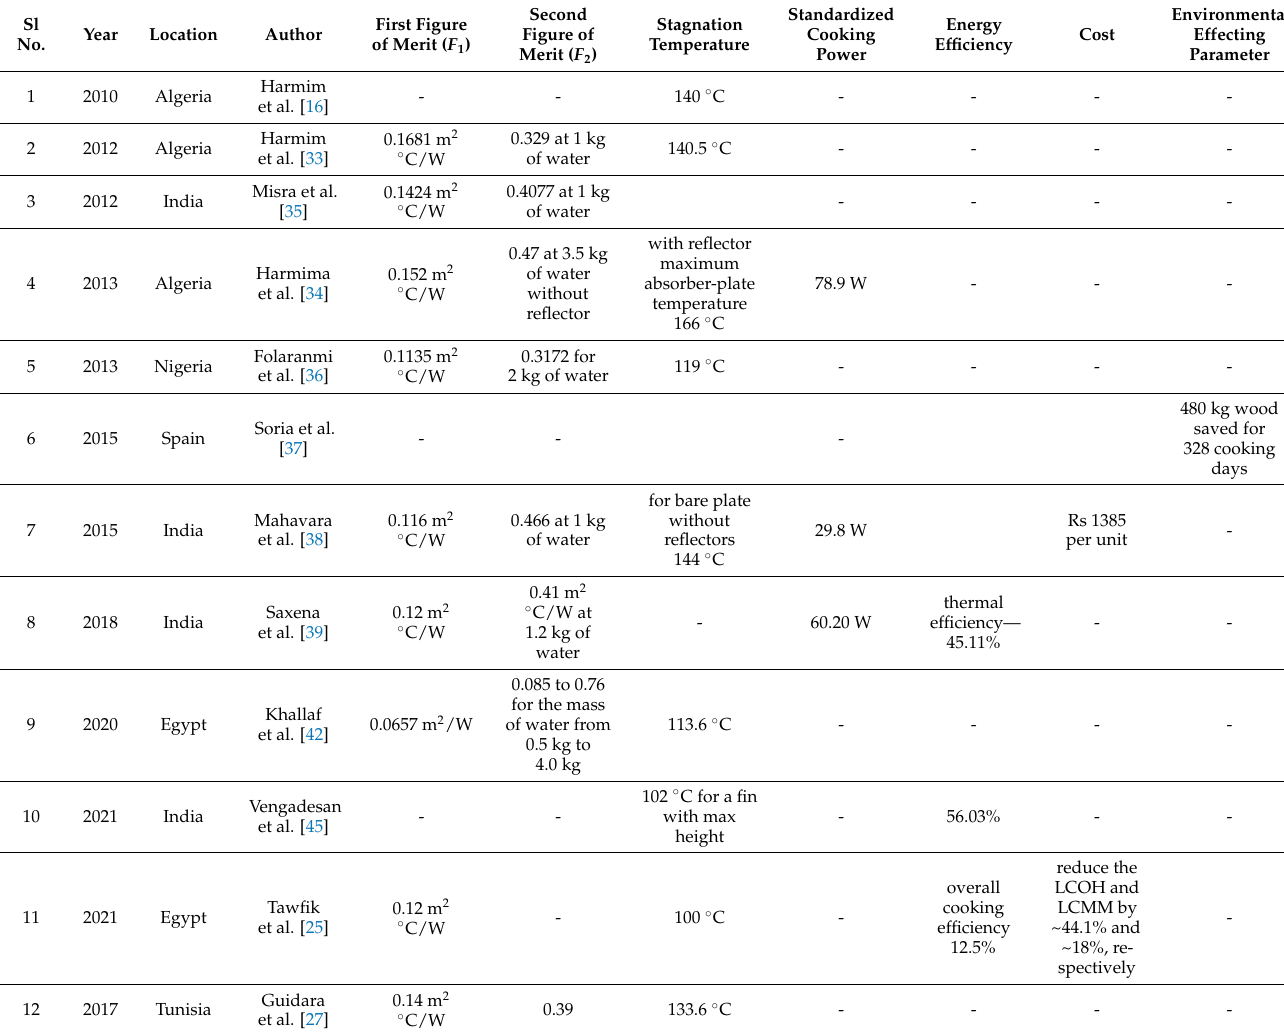
Table 4. Performance Parameters; Energy efficiency; Cost of various solar